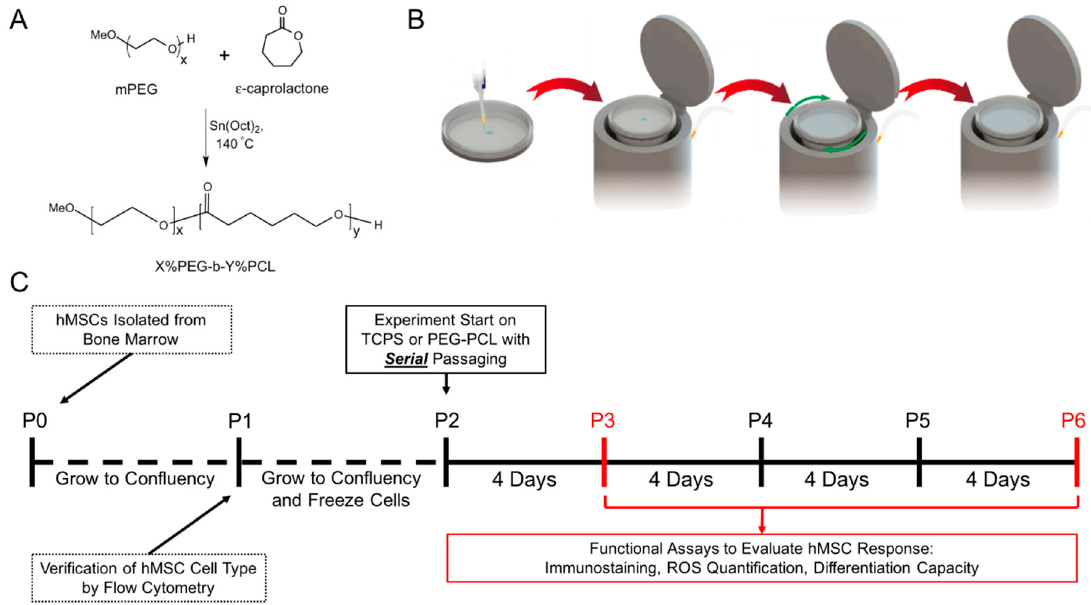
Figure 1. Experimental overview. ( A ) The poly(ethylene glycol)-poly( ε -caprolactone) (PEG-PCL) copolymer was synthesized using methoxy-PEG and ring-opening polymerization of ε –caprolactone; ( B ) polymer films were generated by spin-coating copolymer solution onto coverslips or into Pyrex© petri dishes as shown in the illustration. First, a set volume of 1% w / v PEG-PCL solution was dropped onto coverglass or Pyrex© Petri dishes. The coverglass or dishes were placed into the spin coater and a spin program (green arrows) was applied to the substrates. The PEG-PCL solution was evenly spread out on the surface with the solvent evaporating in the process; ( C ) the timeline of experiments with respect to passage number of the donor human mesenchymal stem cells (hMSCs). Red indicates that passage numbers where imaging or functional tests were performed.